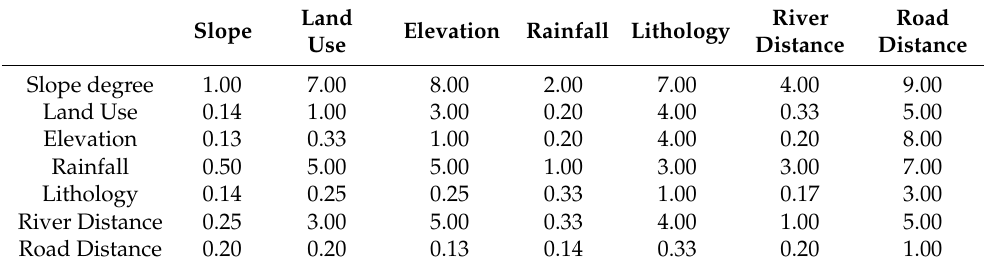
Table 3. Pairwise comparison matrix.